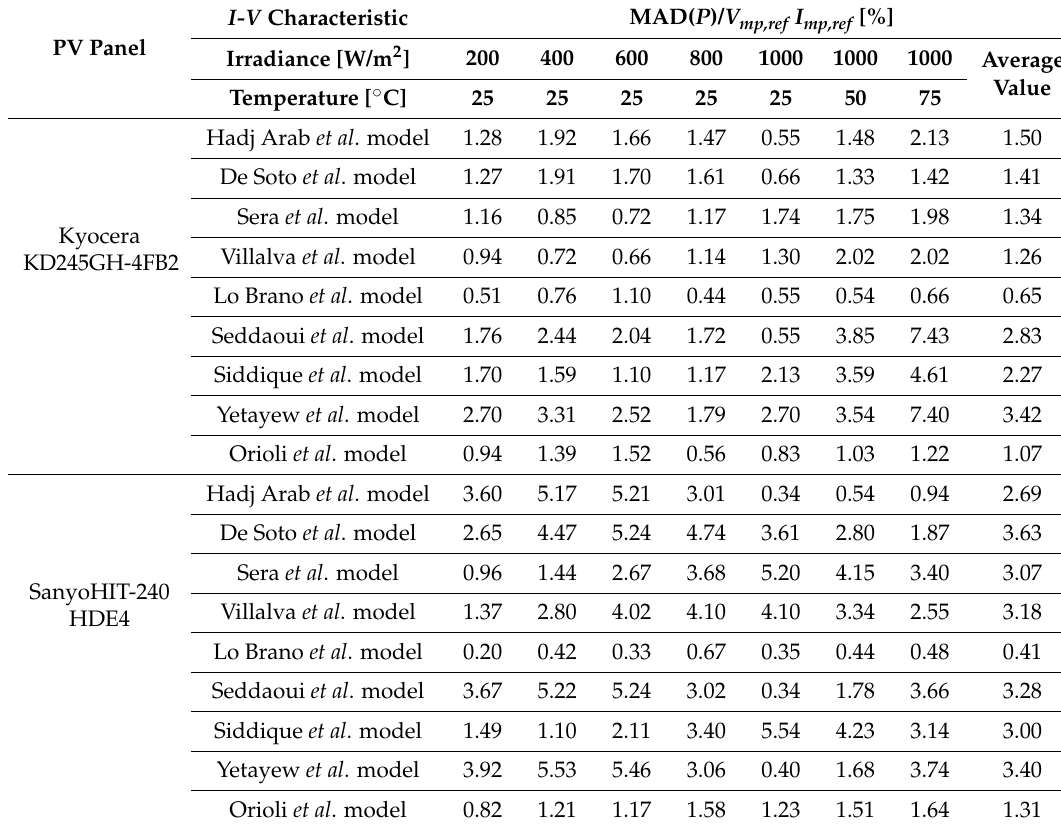
Table 16. Percentage ratio of MAD( P ) to the rated maximum